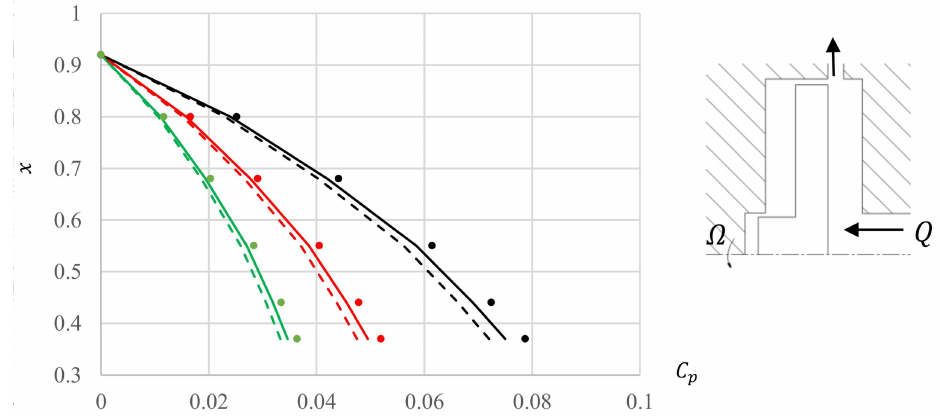
Figure 5. Comparison of radial pressure distribution for Re = 4.15 × 10 6 and G = 0.036. C p : pressure coefficient; G : non-dimensional axial gap; Q : volumetric through-flow rate; x : non-dimensional radial coordinate; Ω : angular velocity of the disk. Colors: Black: C D (cid:48) = 0, Red: C D (cid:48) = 2579, Green: C D (cid:48) = 5159; Solid lines: RSM from Poncet et al. [16]; Dashed lines: Simulation results (SST k − ω ); Points: Measurements by Poncet et al.